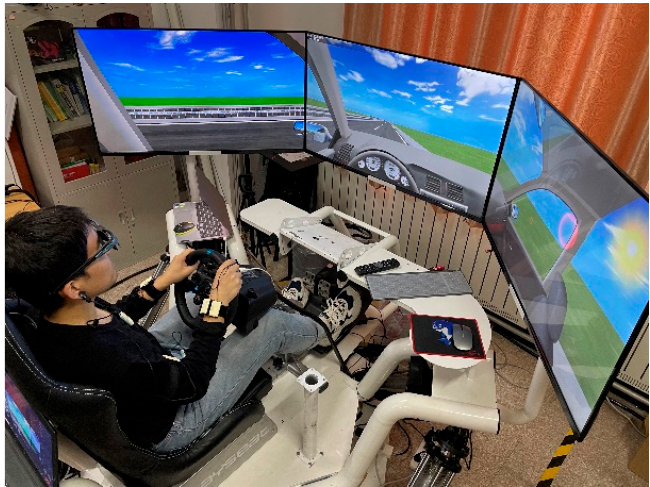
Figure 2. Simulated driving experiment environment.